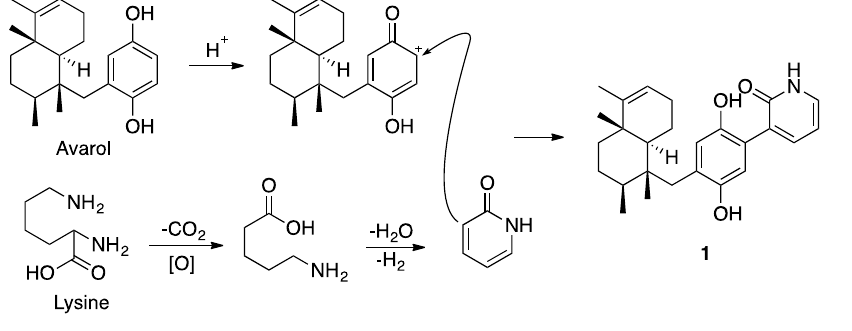
Figure 7. Plausible Biogenetic Pathway of 1